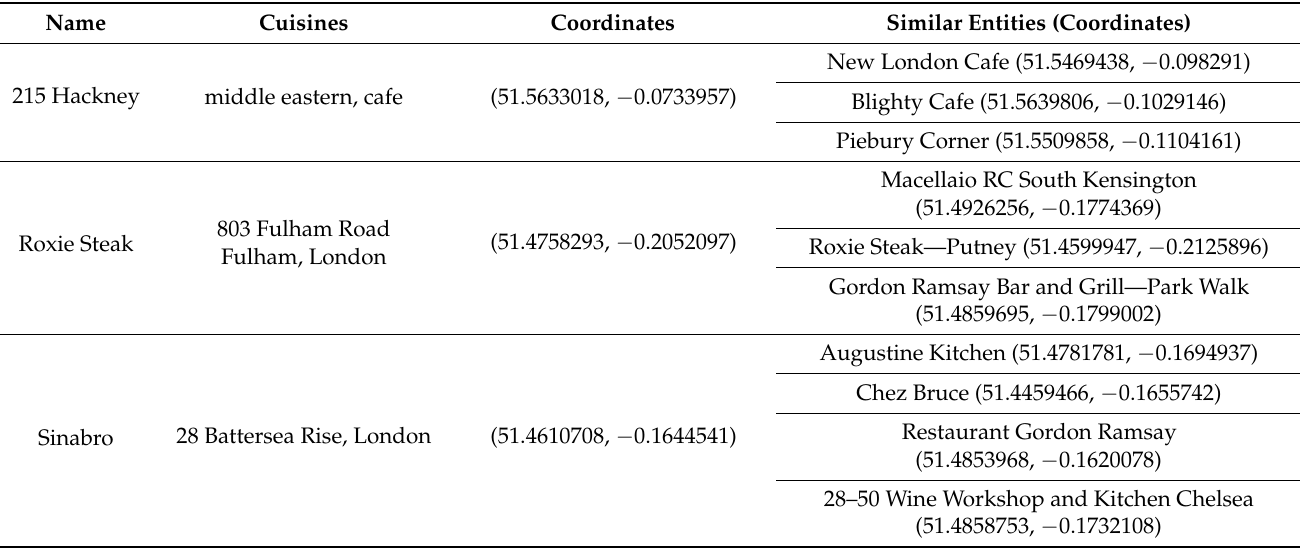
Table 4. Basic information of the three additional restaurants.